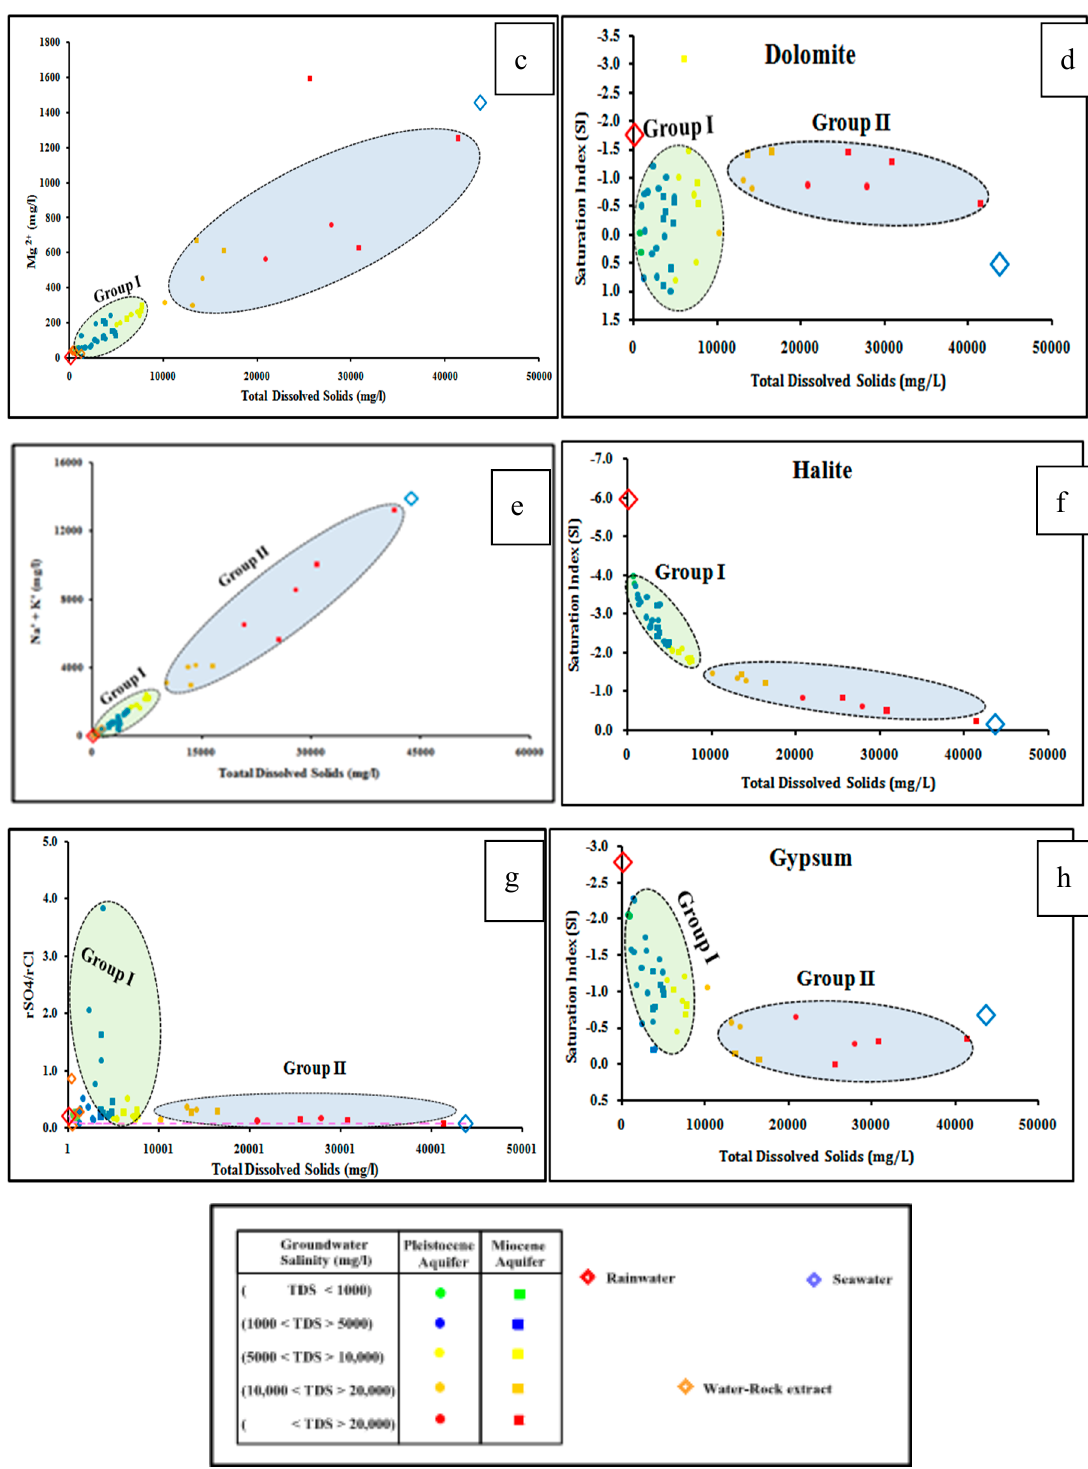
Figure 3. Relationships between the dissolved major ions and the equivalent mineral saturation indices (( a ) Ca , ( b ) Calcite , ( c ) Mg , ( d ) Dolomite , ( e ) Na , ( f ) Halite , ( g ) SO 4 , and ( h ) Gypsum ) versus the total dissolved solids of the studied groundwater samples.